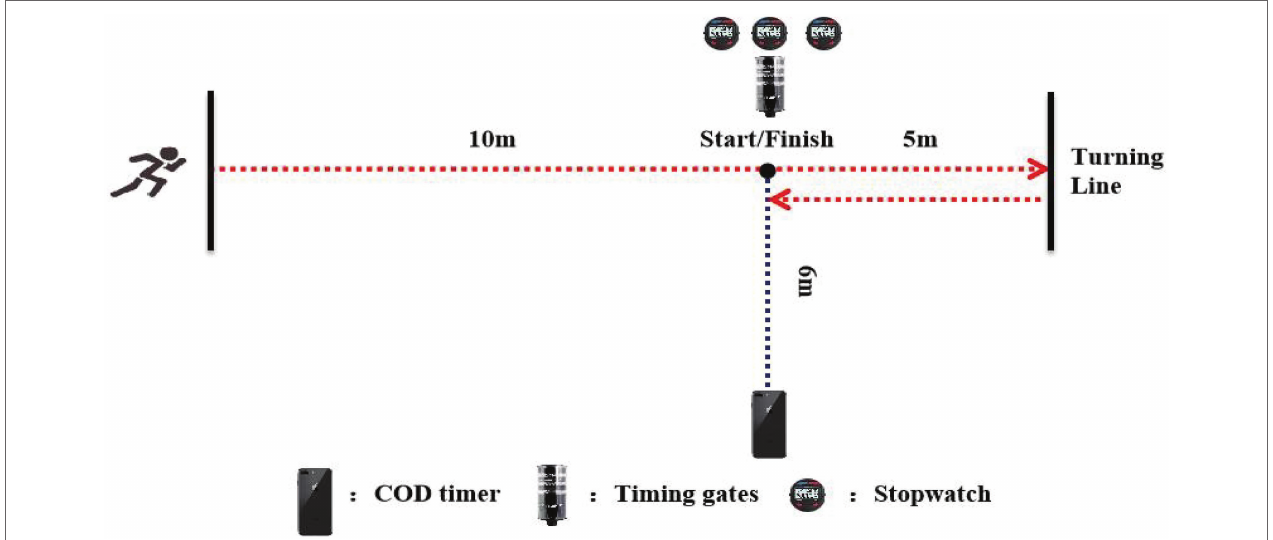
FIGURE 1 | Layout of the 505 COD